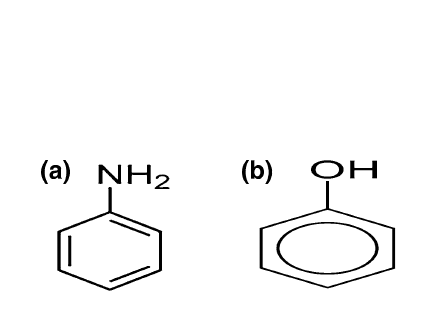
Fig. 1 The chemical structures of a aniline and b